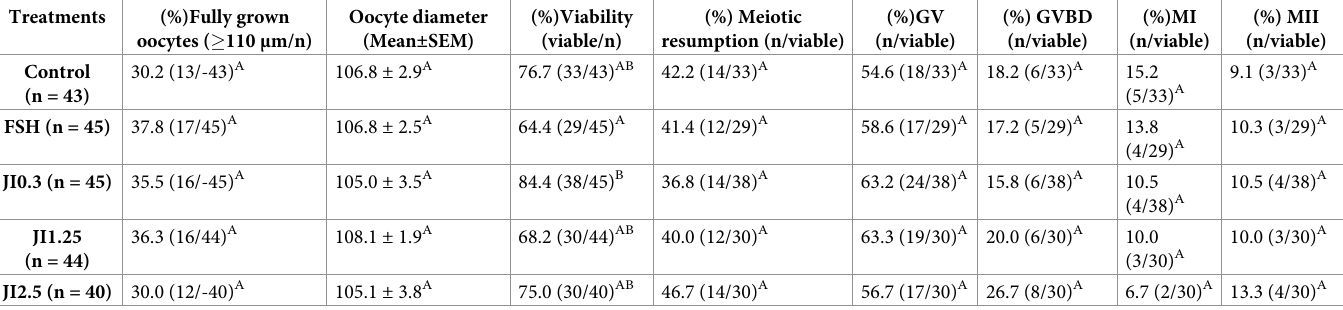
TCM: Tissue culture media 199, FSH: recombinant bovine follicle stimulating hormone, JI: J . insularis . A total of 217 complexes oocyte cumulus cells from secondary follicles grown in vitro were matured (n = 6